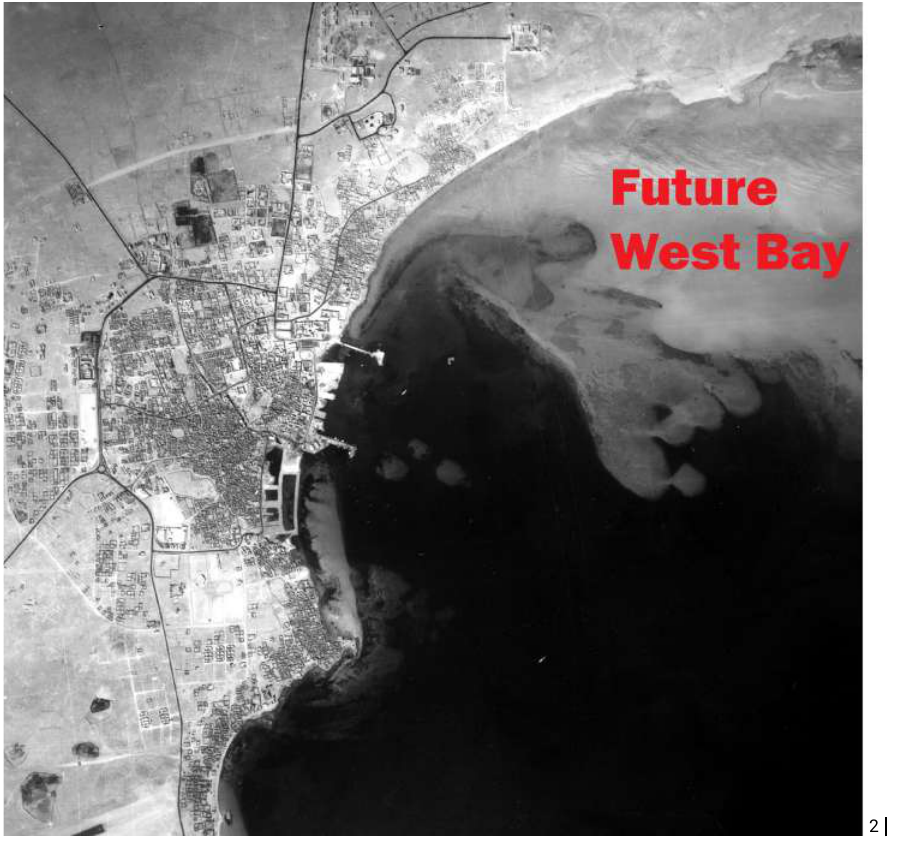
Aerial image of Doha (Source: Hunting Aerosurvey,